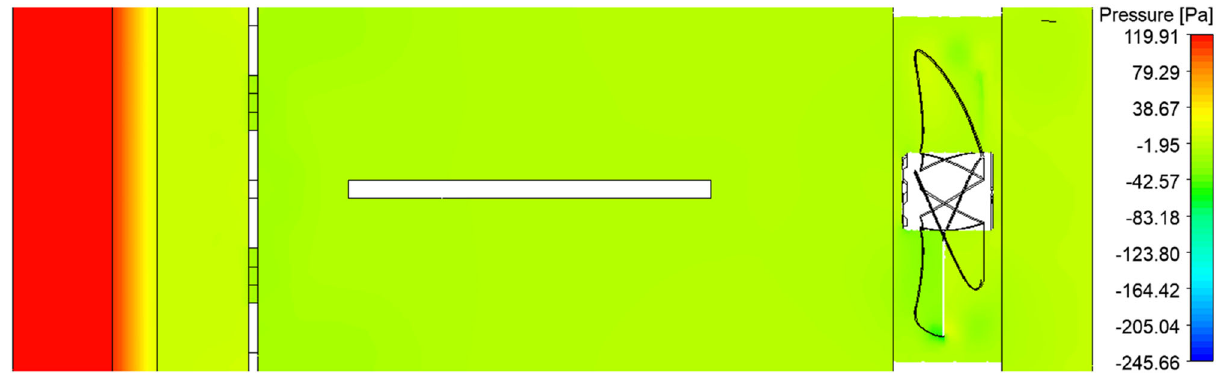
Figure 9. The pressure field at the mid ‐ spanwise plane of the air cleaner and relative to the pressure at a central point after the dust filter.